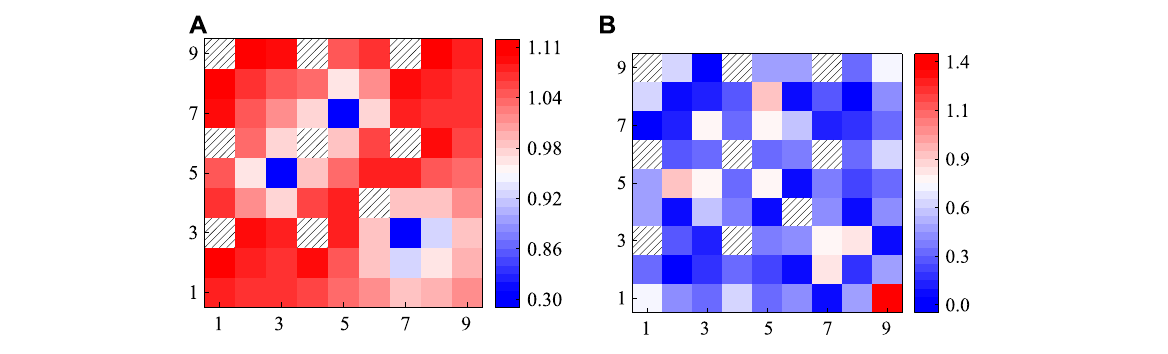
FIGURE 14 Calculation result of pin power of the VERA 2O lattice: (A) referenced normalized pin power; (B) absolute value of relative